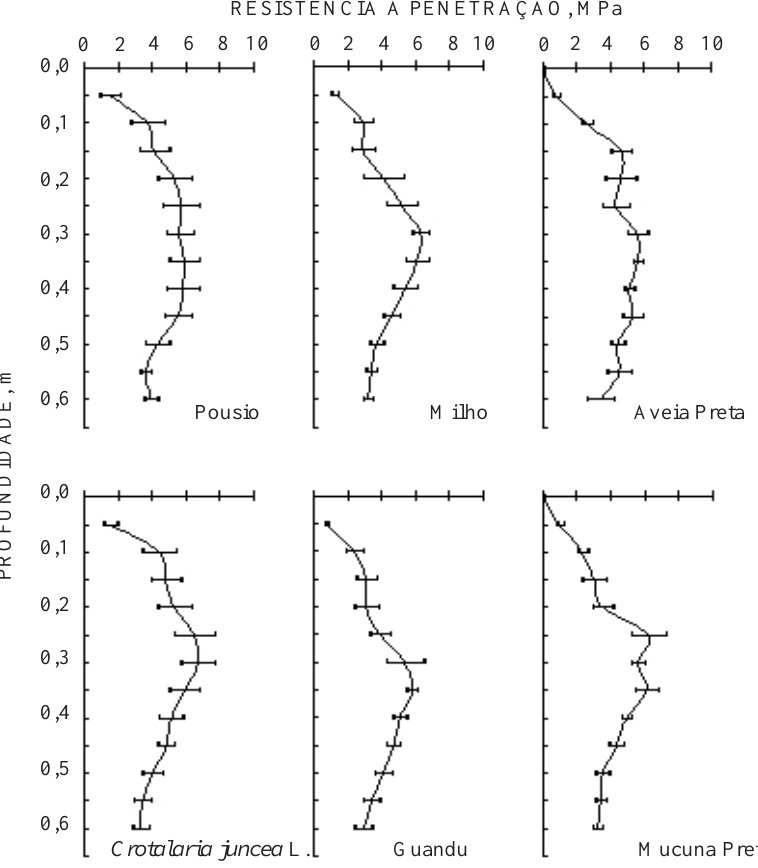
Figura 3. Valores médios de resistência à penetração ± erro-padrão da média, em MPa, com penetrômetro de impacto modelo IAA/PLANALSUCAR, em diferentes profundidades, em Latossolo Vermelho eutroférrico típico cultivado com feijoeiro e após rotação com culturas graníferas e adubos